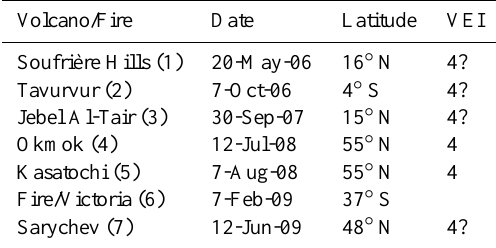
Table 1. List of volcanic eruptions with their corresponding Vol- canic Explosivity Index (VEI) or fires that have produced a plume detected by CALIPSO during the 2006–2009